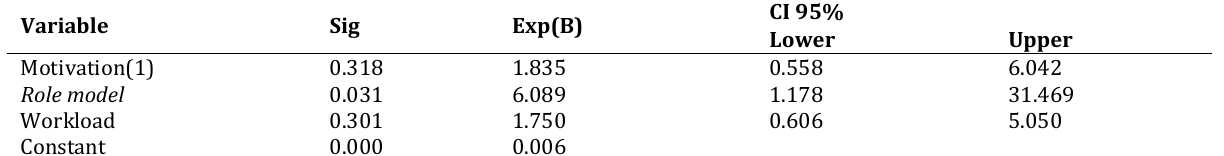
Table 5. The results of the last multivariate modeling selection were the factors related to the handover